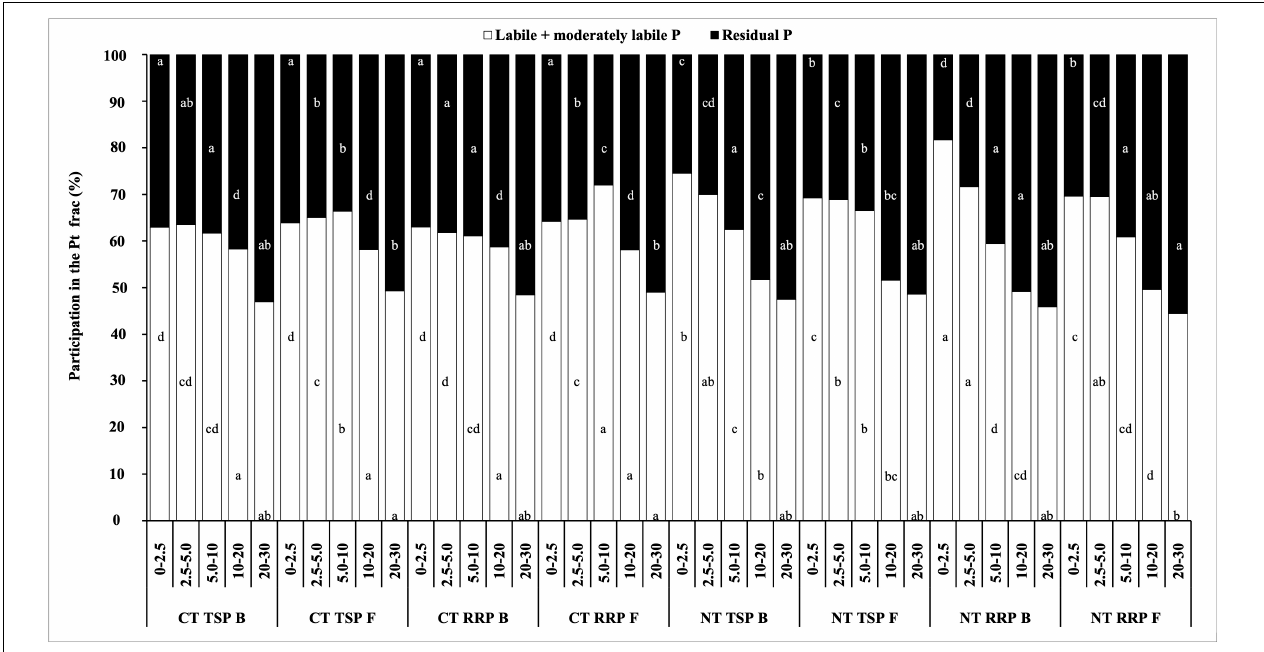
FIGURE 2 | Participation of labile + moderately labile and residual fractions of P in relation to Pt (cid:54) frac in different layers of a very clayey Oxisol after 17 years of cultivation under distinct soil management systems, phosphate fertilizer sources, and application methods. CT, conventional tillage; NT, no-tillage; TSP, triple superphosphate; RRP, reactive rock phosphate; B, broadcast fertilizer application; F, furrow fertilizer application. Different letters represent significant differences between treatments in a given soil layer and P fraction, according to Fischer’s LSD test ( P < 0.05).